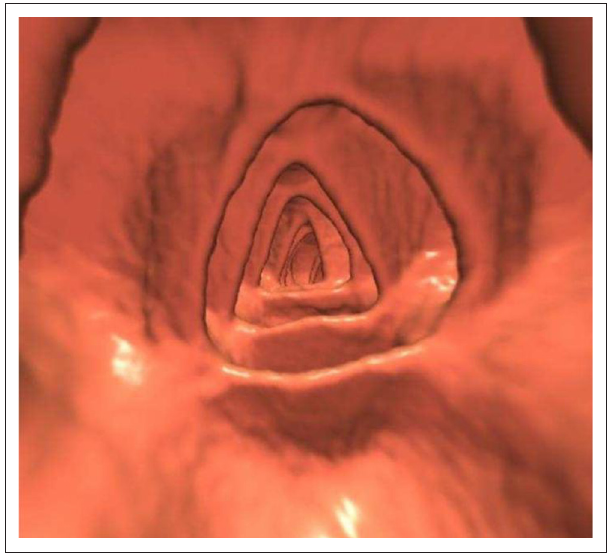
FIGURE 12: Triangular folds in the right colon (caecum to splenic